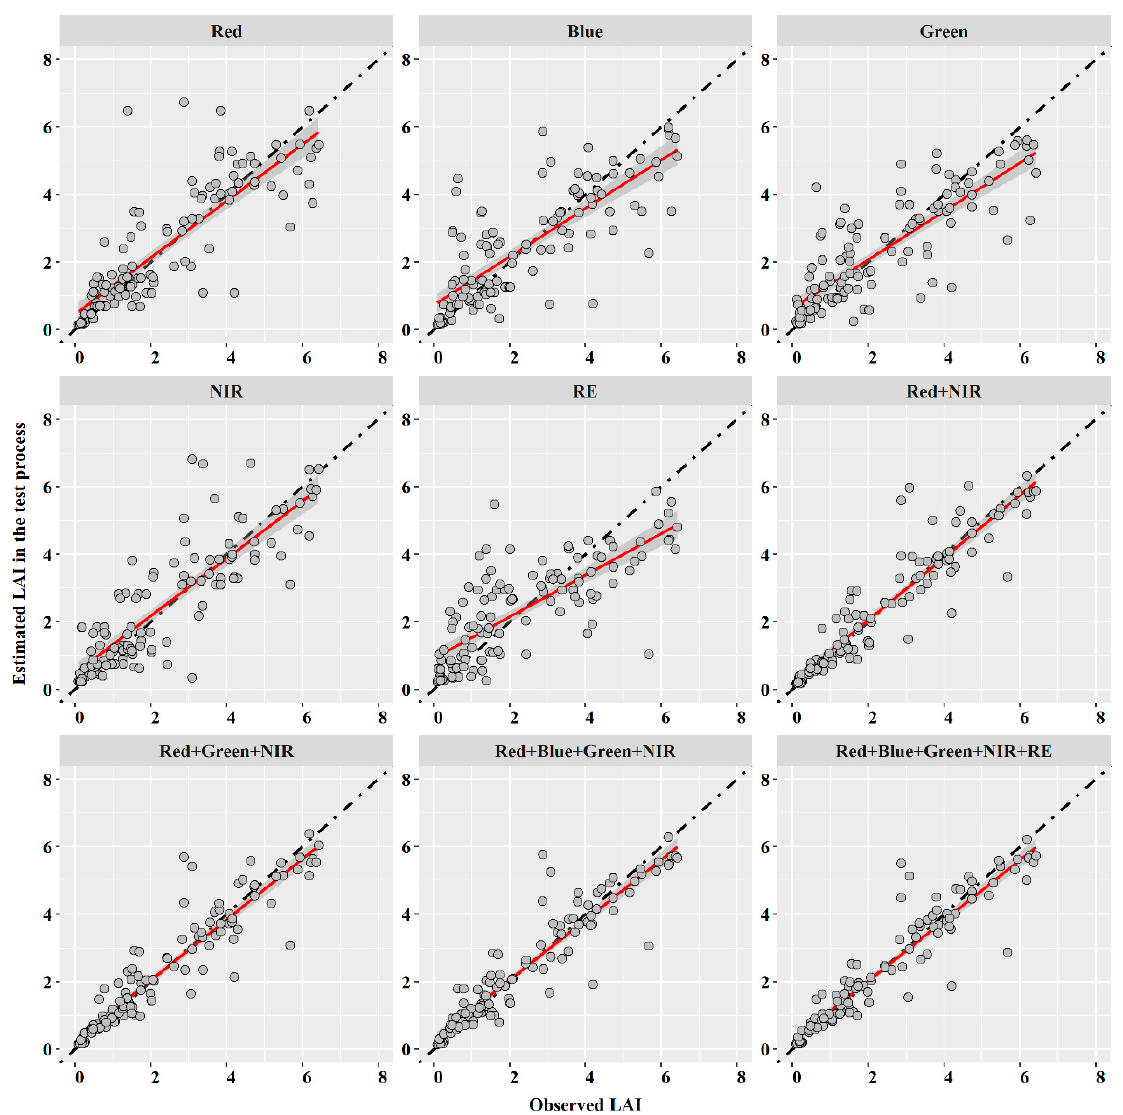
Figure 6. Relationship between observed and estimated leaf area index (LAI) of rice by random forest model (RF) with multispectral bands (B) in the test process. Dash lines and red solid lines are the 1:1 lines and the linear fitting lines, respectively. The shaded areas indicate the range of 95% prediction bands.